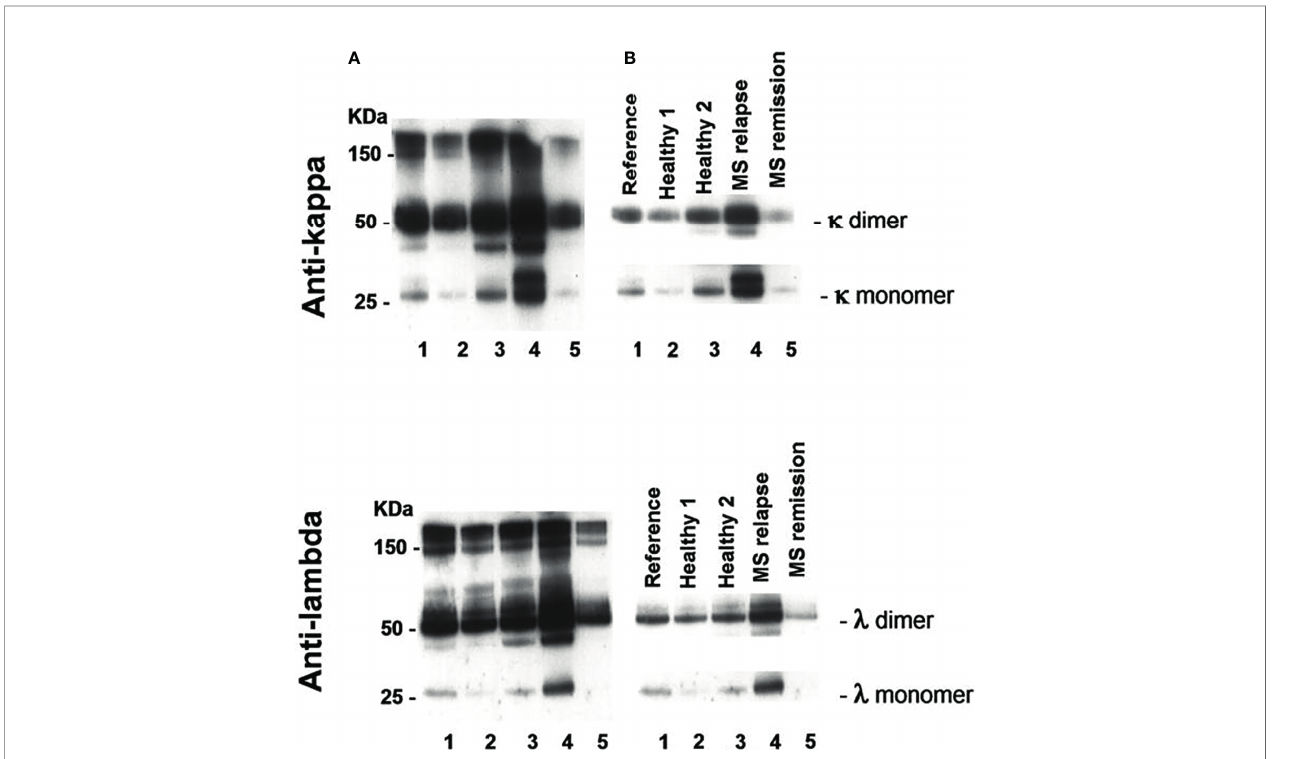
FIGURE 1 | Western blot analysis of saliva FLC monomers and dimers in two healthy individuals (tracks 2 and 3), POMS patient in relapse (track 4) and POMS patient in remission (track 5). Track 1 - reference sample. (A) Exposure to X-ray fi lm to view free and bound light chains: FLC monomers (25 kD), FLC dimers (50 kD), and intact immunoglobulins ( ≥ 150 kD). (B) Exposure to X-ray fi lm to calculate intensity of FLC bands in a linearity range. The electrophoregram demonstrates high saliva FLC levels (monomers and dimers) in POMS patients in relapse as compared to those in the healthy individuals and in the POMS patients in